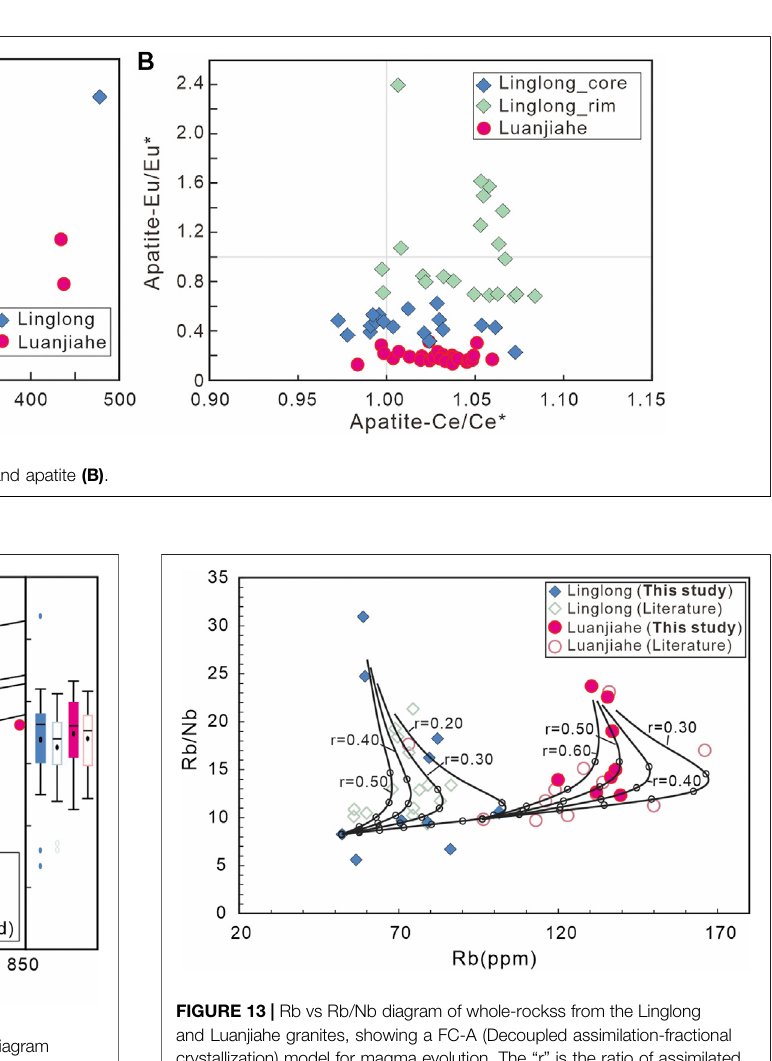
FIGURE 12 | Zircon temperature and oxygen fugacity (log f O 2 ) diagram for the Linglong and Luanjiahe granites. Oxygen fugacity and Ti temperatures were calibrated using methods proposed by Trail et al. (2011) and by Ferry and Watson (2007), respectively. The activities of SiO 2 and TiO 2 are assumedtobe1.0and0.7forLinglonggranitesinceitcontainstitaniteandno rutile, and 1.0 and 0.6 for Luanjiahe granite which has no titanite and rutile. FMQ = fayalite-magnetite-quartz buffer curve, HM = hematite-magnetite buffer curve, MW = wüstite-magnetite buffer curve, and NNO = nickel-nickel oxide buffer curve. The literature data are from Li X.-H. et al., 2019.